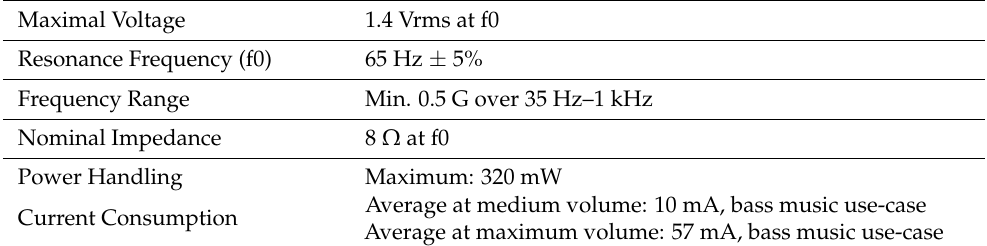
Table 2. Haptic, Electrical, and Acoustic Characteristics of Lofelt L5 [35].